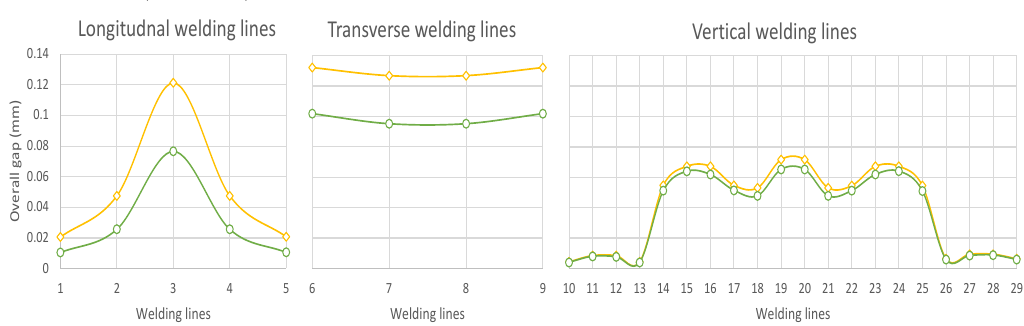
Figure 10. Total gap between the welding lines and plate, after welding each line.